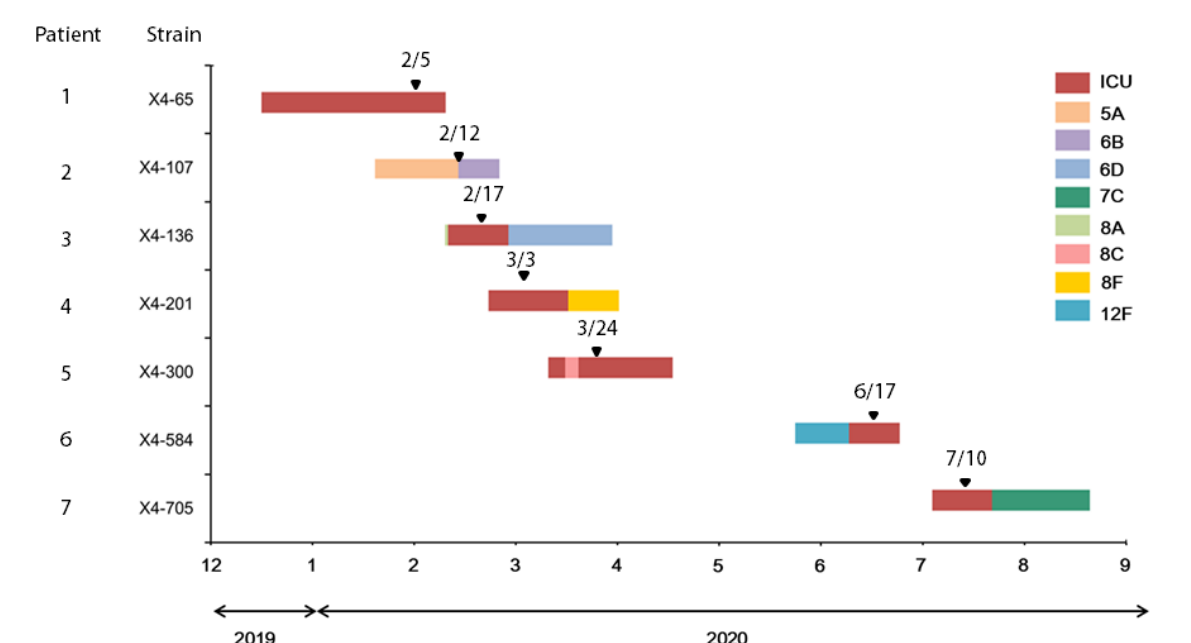
Figure 4. Medical history timeline of the patients with tet (X6)-carrying A. baumannii infection: Duration of hospital stay for each patient are shown. Intensive care unit is indicated in red, and general wards are shown in different colors representing different wards. The isolation time of tet (X6)-carrying A. baumannii was indicated by an arrowhead.